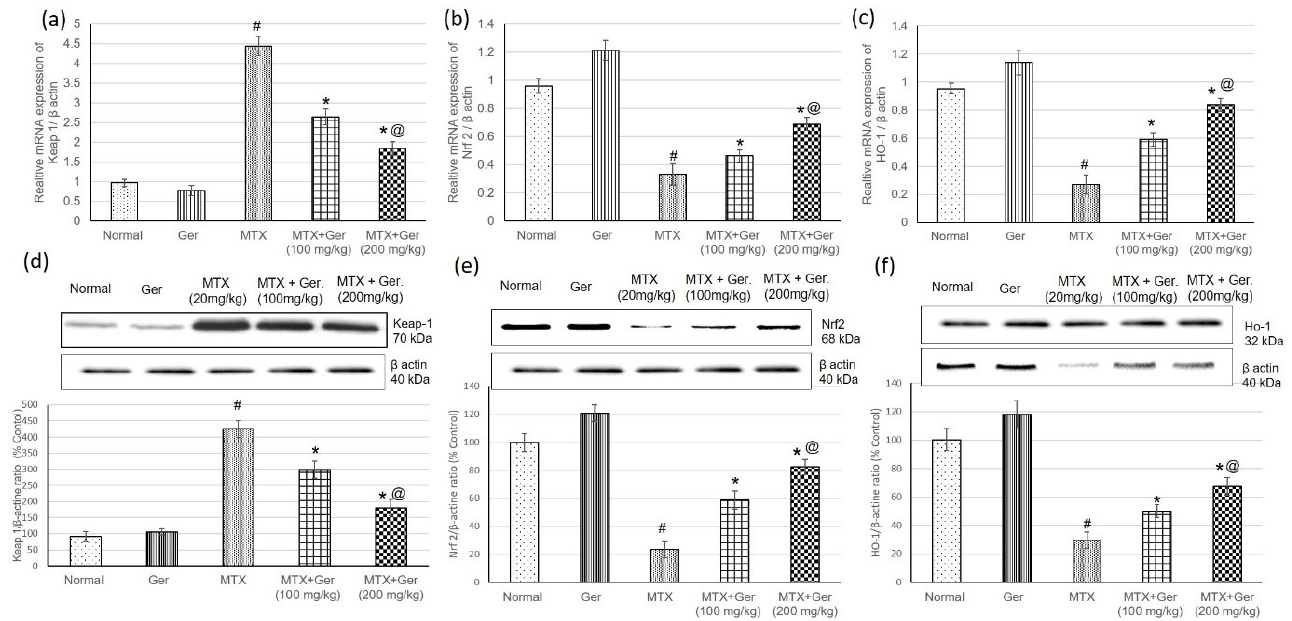
Figure 3. Effects of treatment with Ger (100 and 200 mg/kg) for 19 days on the Keap-1/Nrf2/HO-1 signaling pathway including mRNA expression on ( a ) Keap-1, ( b ) Nrf2 and ( c ) HO-1 levels and on protein expression of ( d ) Keap-1, ( e ) Nrf2 and ( f ) HO-1 levels in MTX-induced AKI in rats ( n = 6). All values are expressed as mean ± SD. #, statistically significant from normal group; *, statistically significant from MTX-only group; @, statistically significant from MTX + Ger 100 mg/kg group ( p < 0.05) using one-way ANOVA followed by Tukey’s post hoc